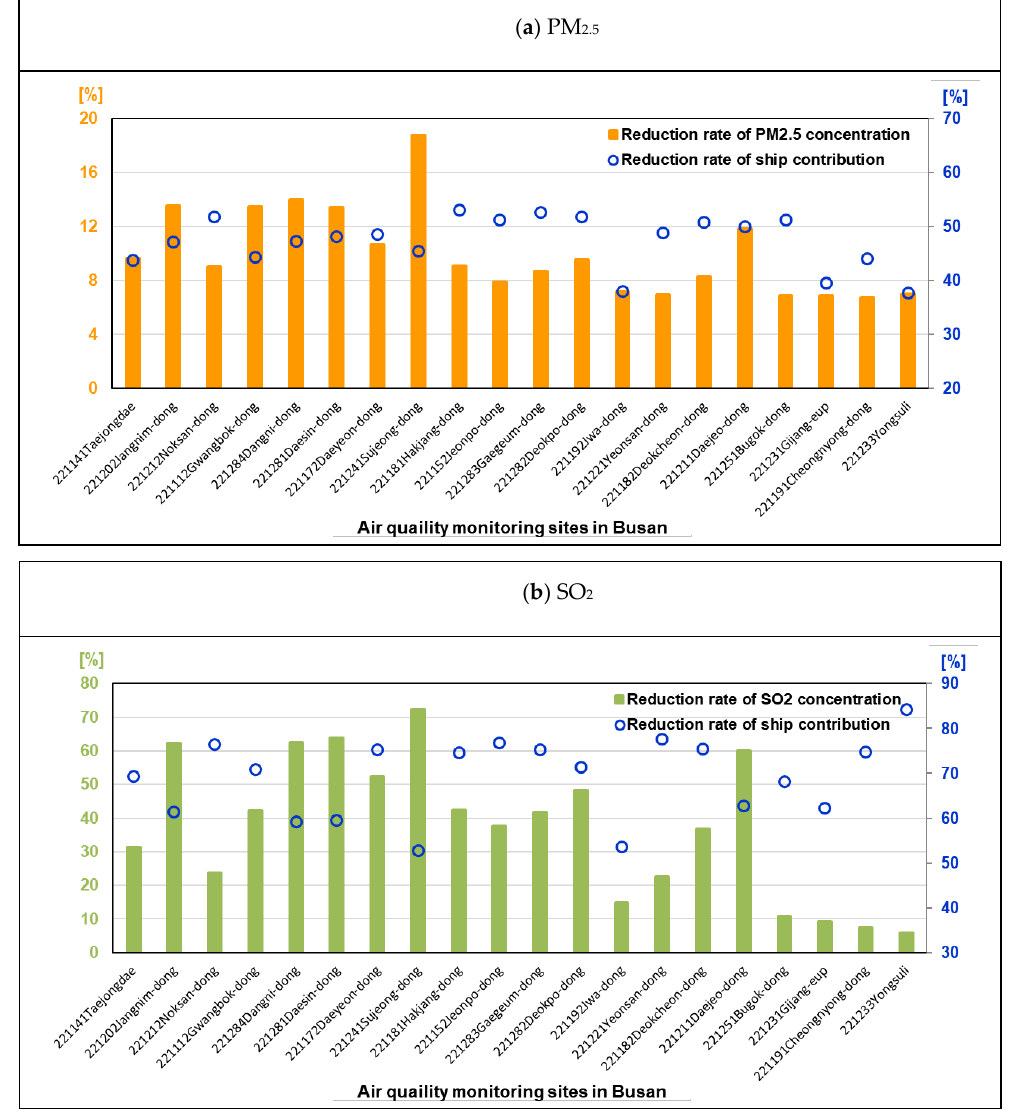
Figure 11. Annual average reduction rates of ( a ) PM 2.5 and ( b ) SO 2 concentrations from shipping emissions in Busan caused by low-sulfur fuel.